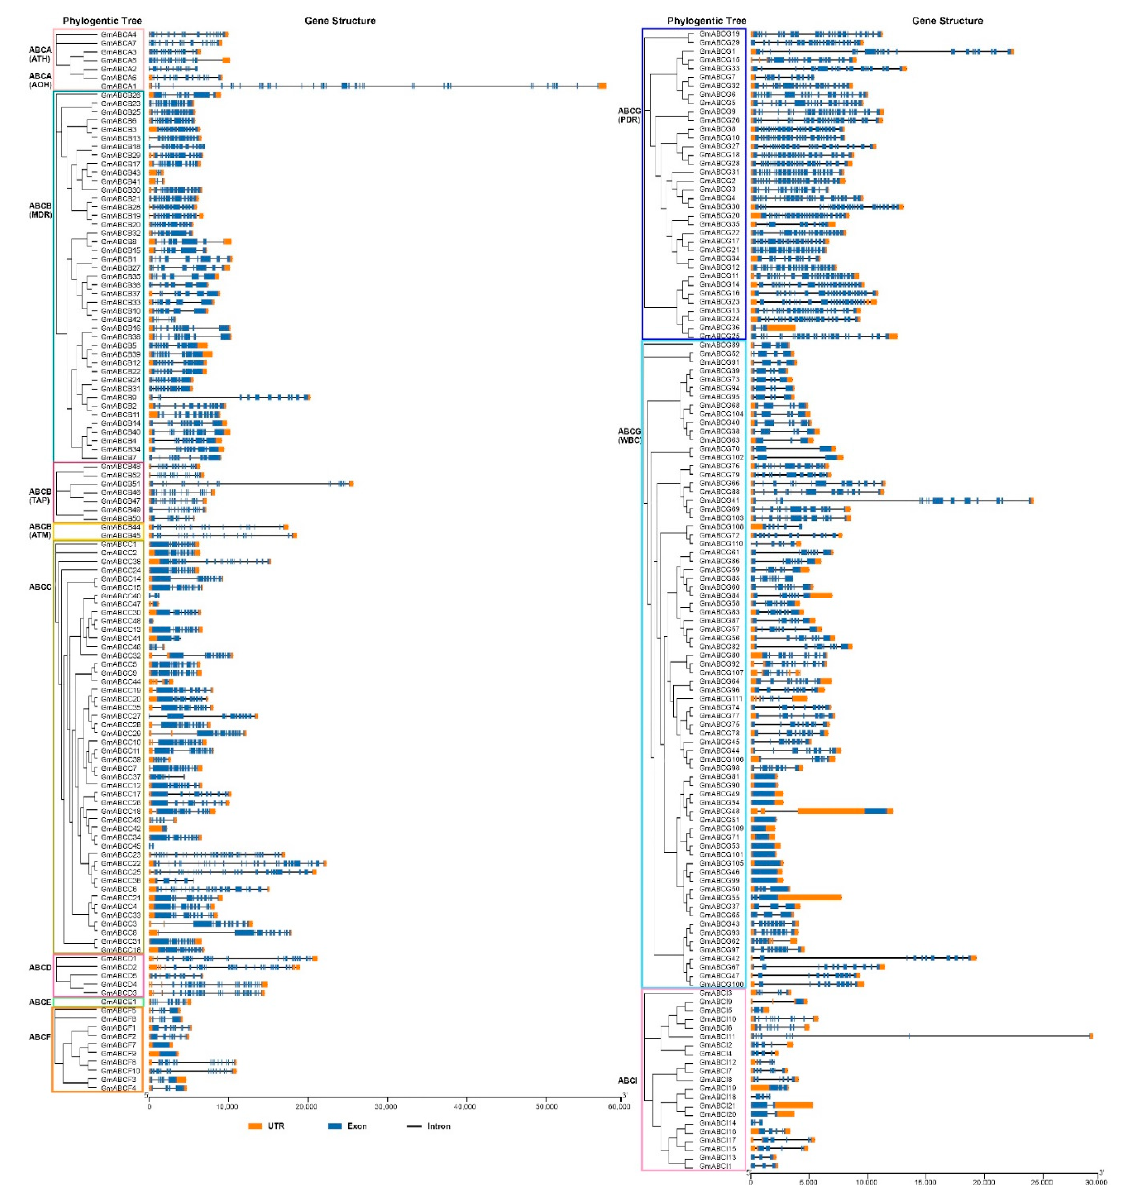
Figure 3. Gene structures of subfamilies GmABCA—GmABCG in soybean. Orange boxes, blue boxes, and black lines indicate UTRs, exons, and introns, respectively. The exon and intron length are calculated by the scale at the bottom.